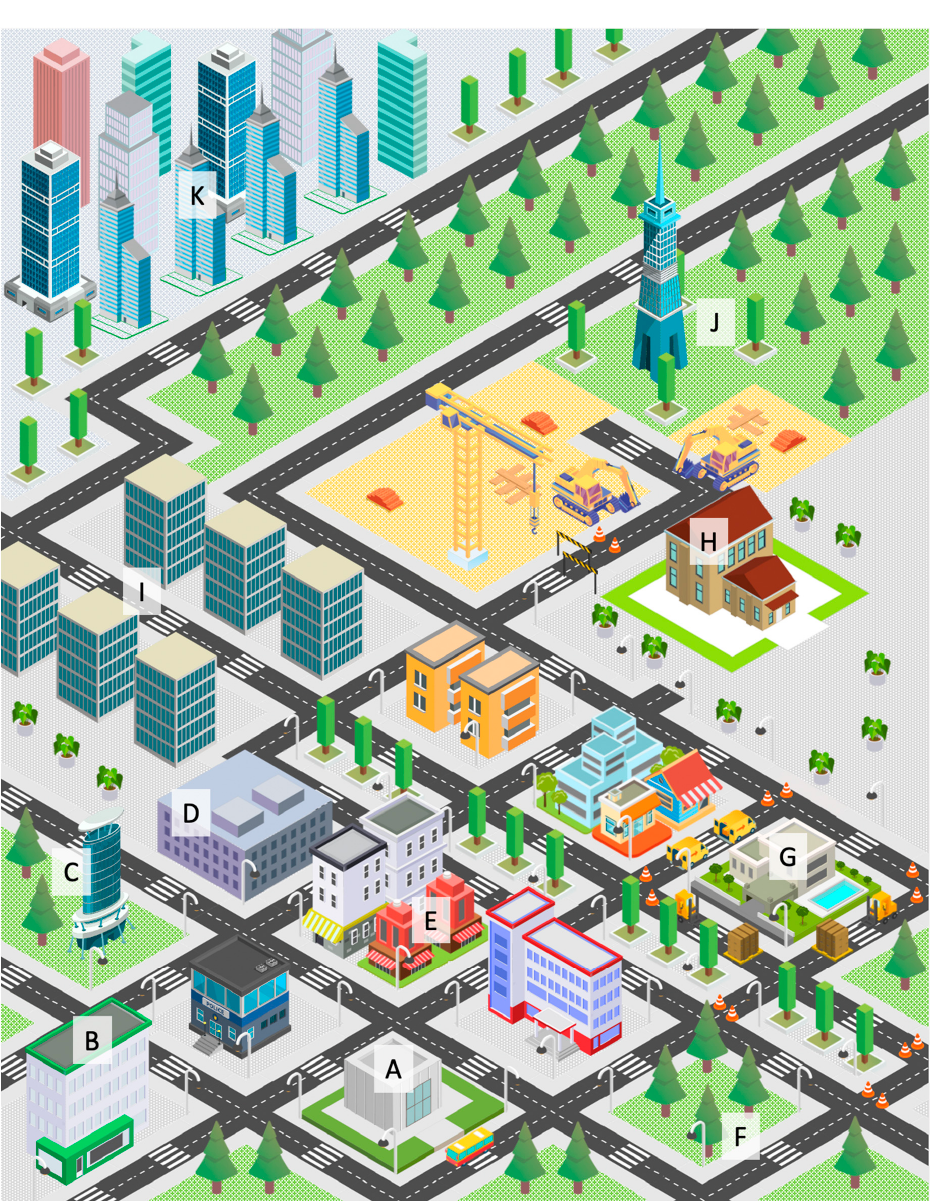
Figure 4. Map of a hypothetical city (Source: Own elaboration).